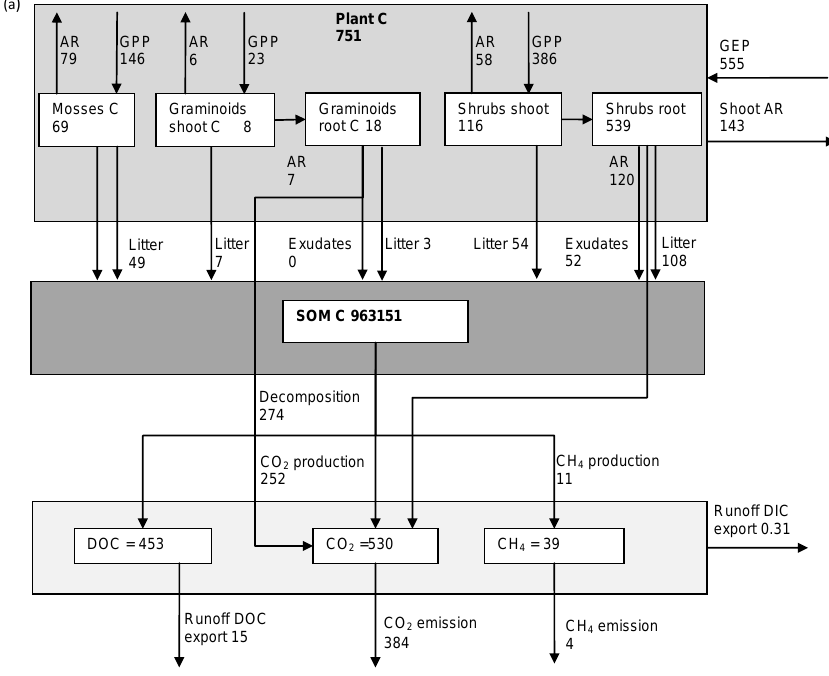
Figure 10. Carbon budget (a) and nitrogen budget (b) for the Mer Bleue peatland based on simulated averages from 1999 to 2004. Pools are in g m -2 and fluxes are in g m -2 year -1 .